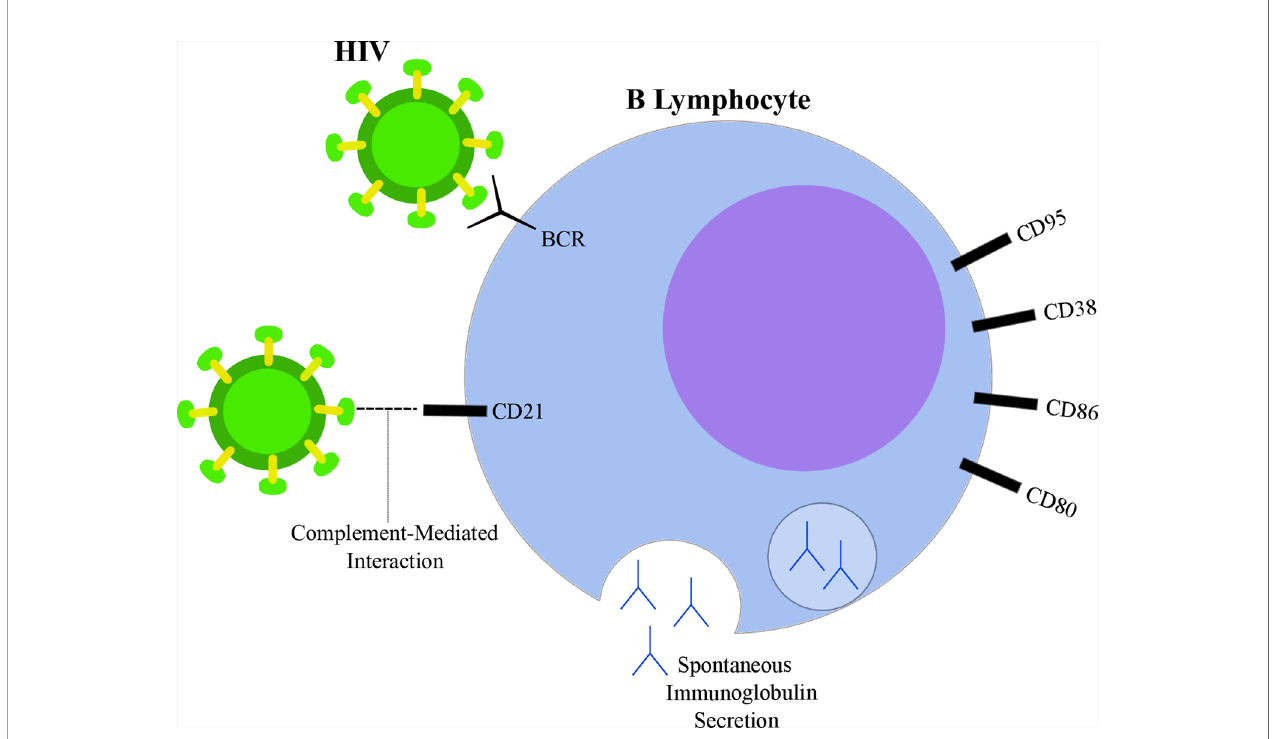
FIGURE 2 | Highlights of HIV-induced B lymphocyte alterations. HIV particle (green) is able to bind B lymphocyte (blue) through direct interactions with surface immunoglobulins (B-cell receptor, BCR) and through CD21 interactions mediated by complement proteins. Spontaneous immunoglobulin secretion leading to hyperglobulinemia is observed in the context of HIV infection, as well as alterations in surface markers, such as increased expression of CD80, CD86, CD38 and